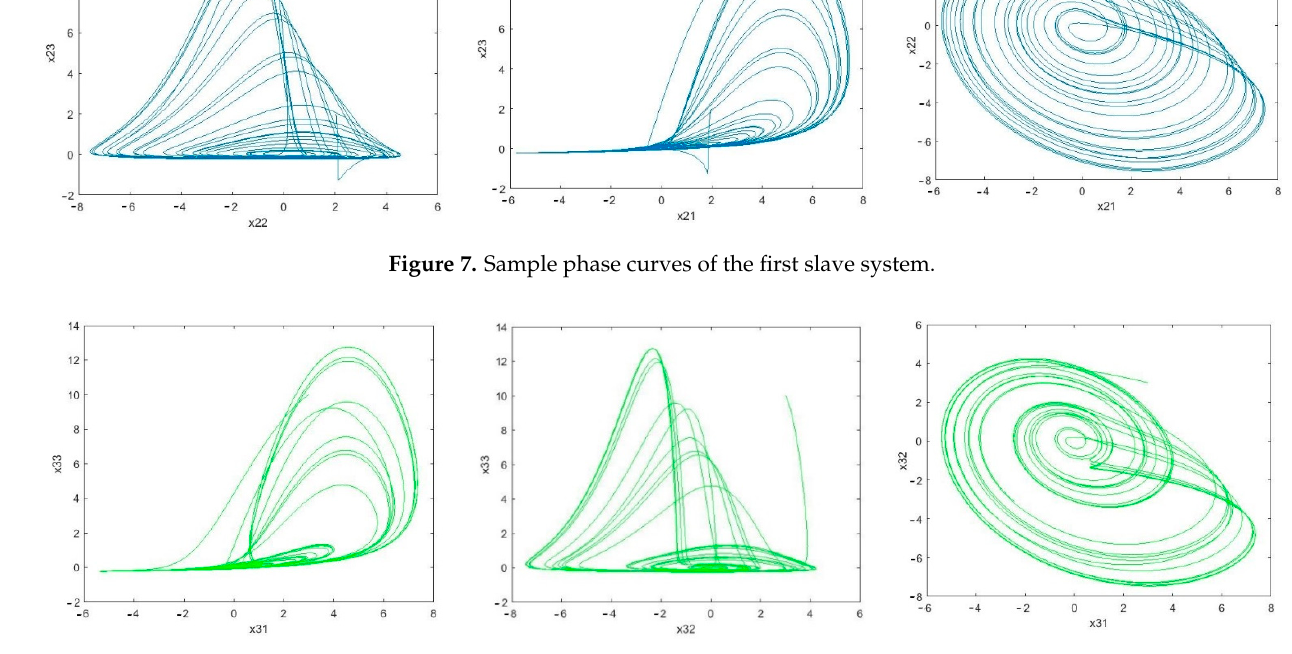
Figure 8. Sample phase curves of the second slave system.